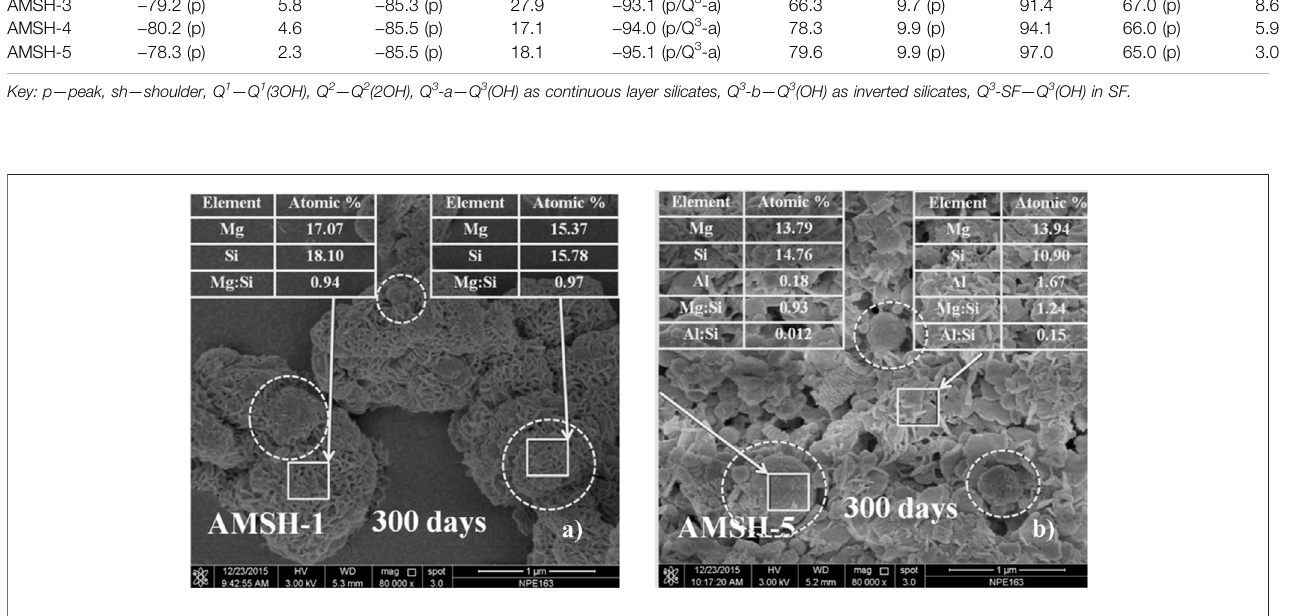
Frontiers in Materials |